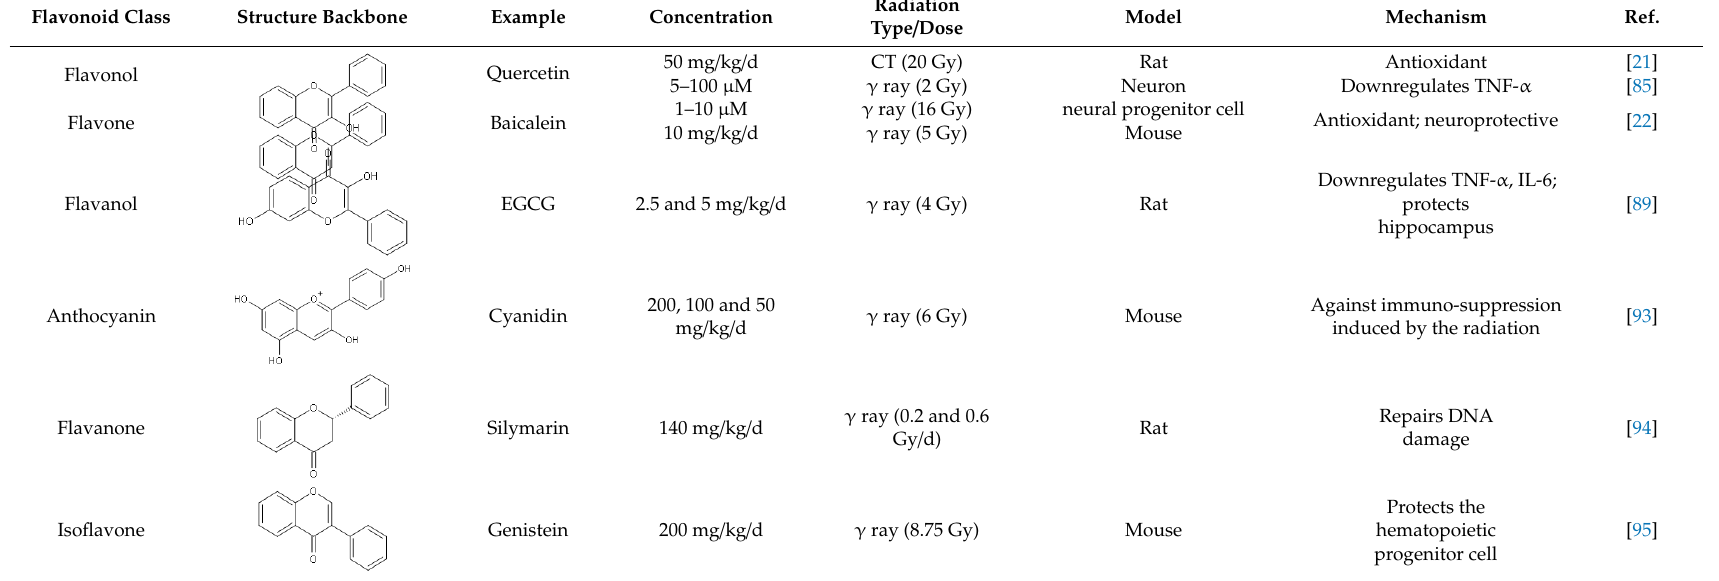
Table 1. Classification, structure backbone and examples of the main classes of flavonoids.